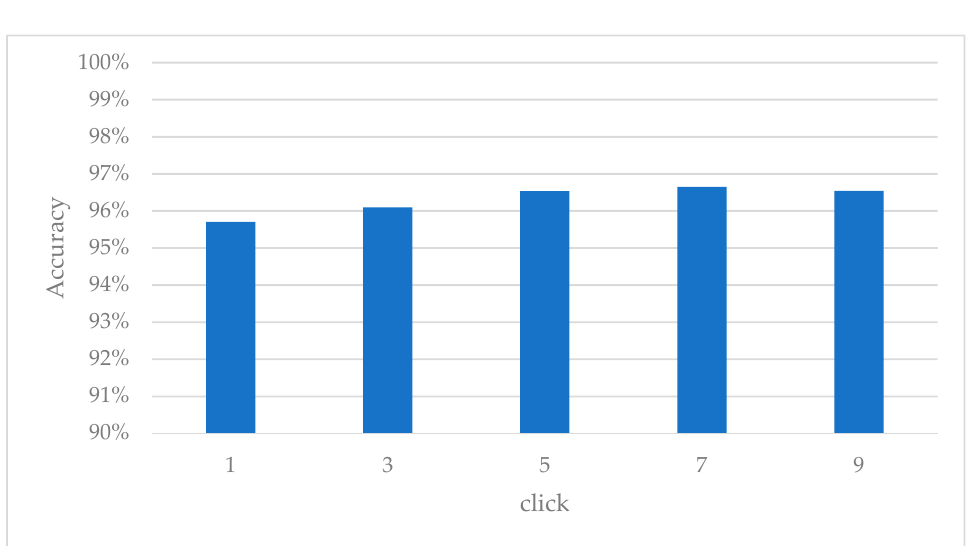
Figure 8. Accuracy comparison among 1–9 click sliding windows.